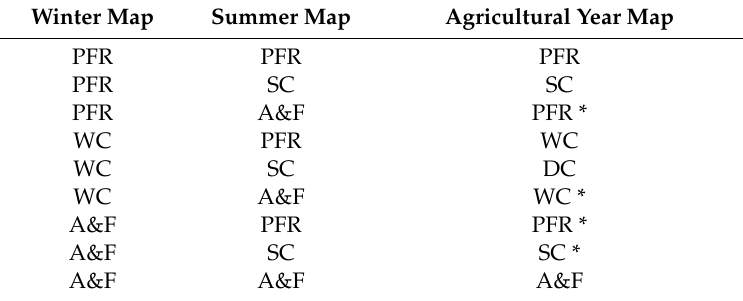
Table 2. Rules for the allocation of LULC in the agricultural year maps based on combining what happened in the maps of the winter and summer agricultural campaigns. WC: Winter Crops, SC: Summer Crops, DC: Double Crops, PFR: Perennial Forage Resources, A&F: A ff orestations and Forests. Winter